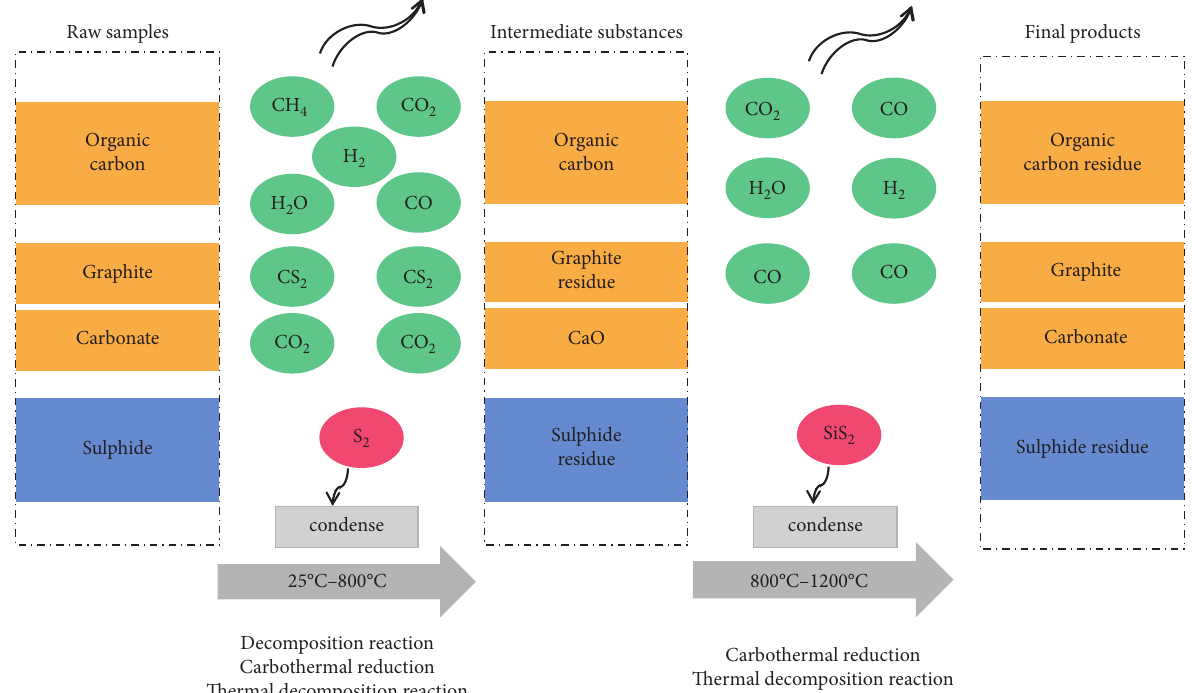
Figure 12: The main reaction process of sulfide ores and carbonaceous matters.